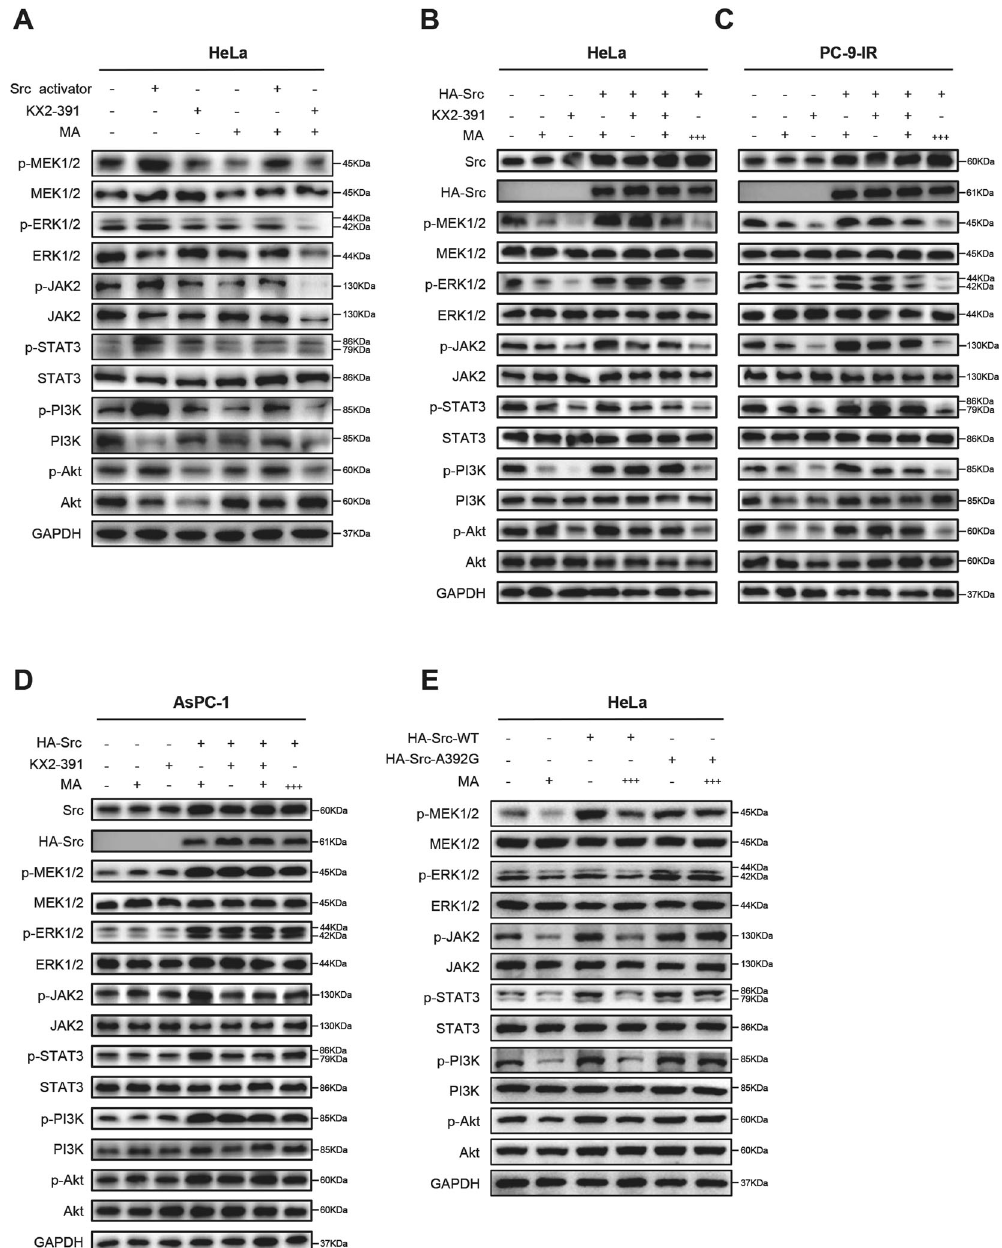
Fig. 6 Involvement of Src in matrine-mediated phosphorylation signaling pathways. A HeLa cells were treated with Src activator (50 nM) or Src inhibitor KX2-391 (100 nM), and then exposed to matrine (2.5 mg/mL) for 24 h, respectively. The phosphorylation levels of MAPK/ERK, JAK2/STAT3, and PI3K/Akt signaling pathways were examined. GAPDH was used as a control. B – D Human cervical cancer cell HeLa, ge fi tinib- resistant human lung cancer cell PC-9-IR, and human pancreatic cancer cell AsPC-1 were transfected with plasmid pcDNA3.1-HA-Src, then treated with matrine, KX2-391(100 nM), and excessive matrine, respectively. The phosphorylation levels of MEK1/2, ERK1/2, JAK2, STAT3, PI3K, and Akt in HeLa ( B ), PC-9-IR ( C ), and AsPC-1 ( D ) were detected by western blot, respectively. GAPDH was used as a control. E Excessive matrine treatment could decrease the phosphorylation levels of various signaling proteins in HeLa cells overexpressing pcDNA3.1-HA-Src-WT, but could not do so in HeLa cells overexpressing pcDNA3.1-HA-Src-A392G ( “ + ” : HeLa, 2.5 mg/mL; PC-9-IR, 2.5 mg/mL; AsPC-1, 3.0 mg/mL. “ +++ ” : triple